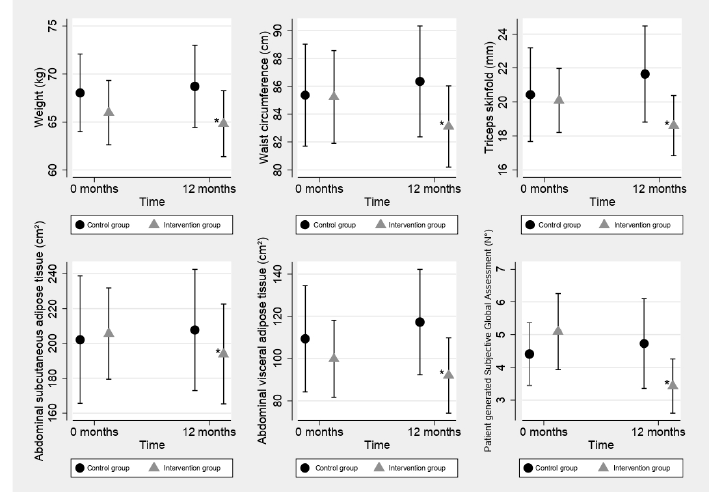
TSF, and VAT, in the expected direction of the intervention; more details are shown in Table 2, Figures 2 and 3.